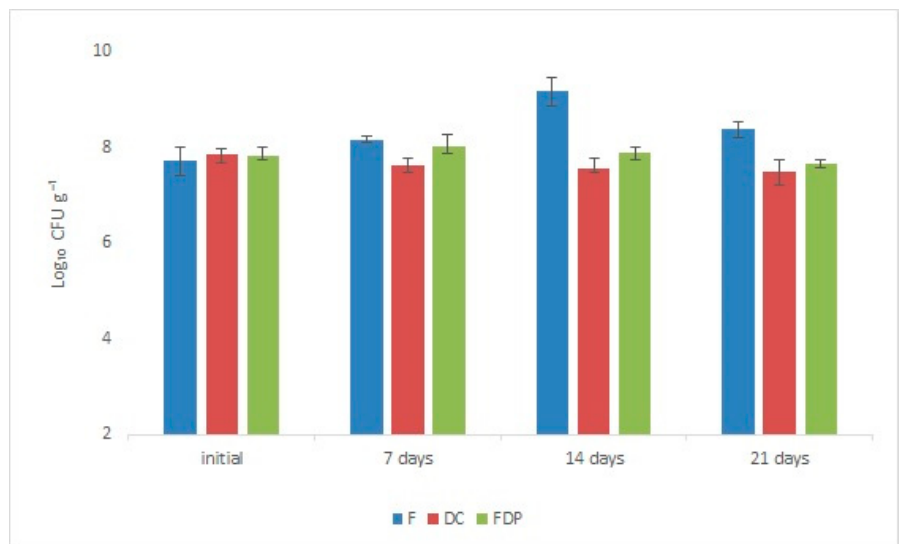
Figure 1. Viability of Lactobacillus plantarum BL3 in the experimental variants during 21 days of storage: F—Fresh beetroot cubes, DC—dried chips of red beet, FDP—freeze dried powder (data are